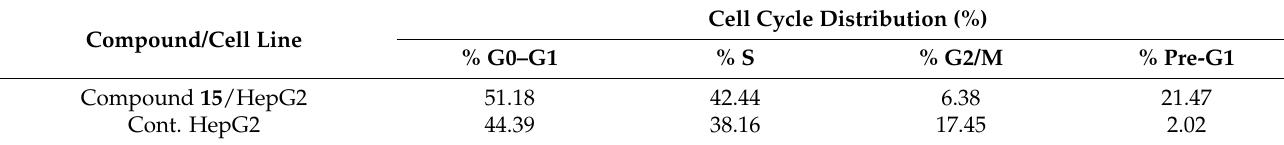
Table 3. Effect of compound 15 on cell cycle progression in HepG2 cells. Table 3. E ff ect of compound 15 on cell cycle progression in HepG2 cells. Table 3. E ff ect of compound 15 on cell cycle progression in HepG2 cells.